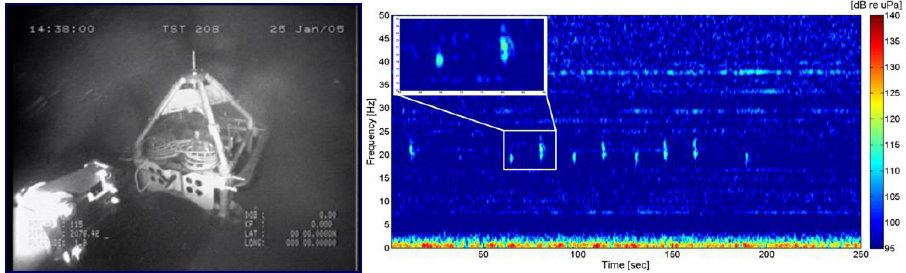
Figure 4. Left: The NEMO-SN1 multidisciplinary observatory deployed at the test site of Catania. Right: Spectrogram of 250 second data showing 18 Hz fin whale vocalisations